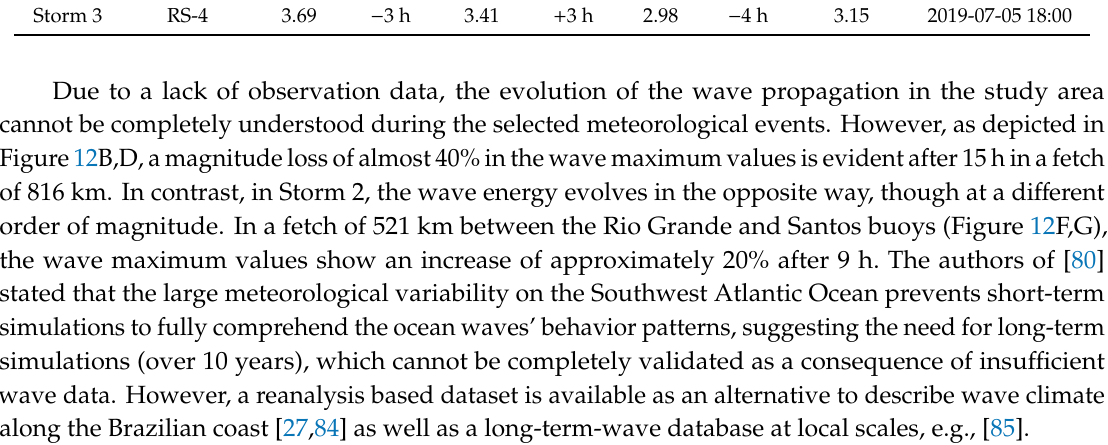
Table 3. Maximum Significant Wave Height and timing (values in m).